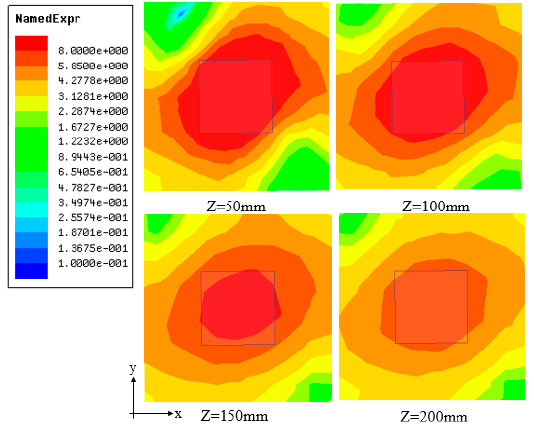
Figure 7. Simulation of the distribution of the electric field component Ex at different heights.